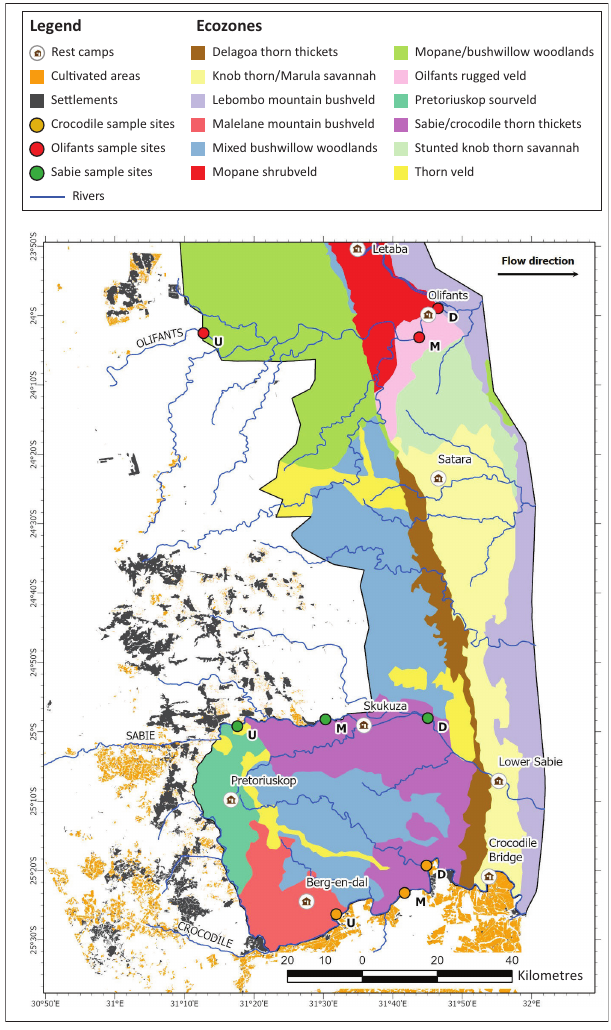
FIGURE 1: Map of the southern part of the Kruger National Park showing residential and agricultural areas, the different ecozones and river systems with the location of sampling